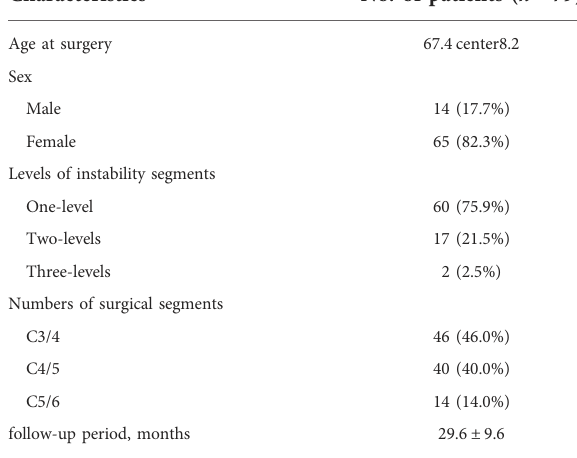
TABLE 1 Basic data of patients (x±, n =79).